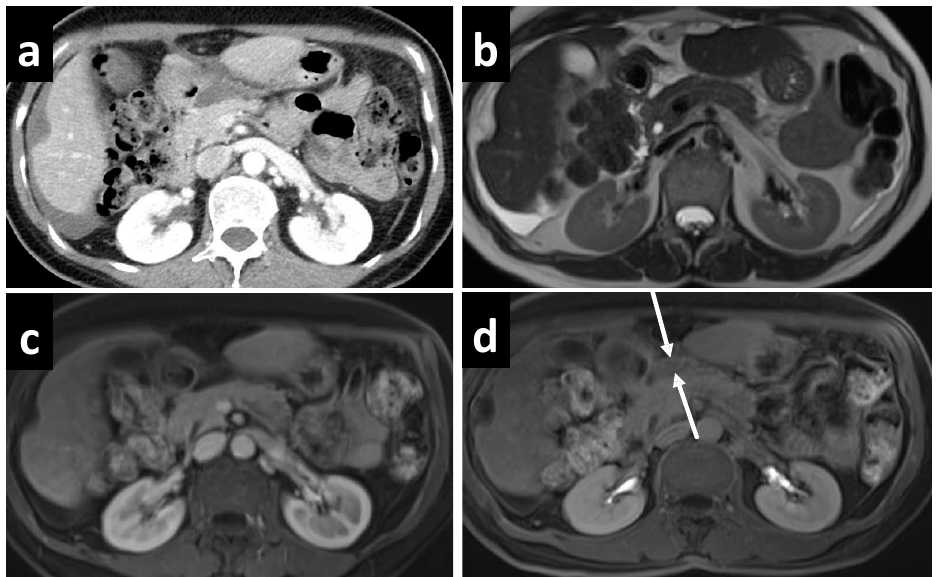
Figure 3. A 61-year-old female with mucinous appendiceal neoplasm, a small amount of fluid is noted within the lesser sac on ( a ) CT and ( b ) T2W MRI. Enhancement within the fluid, however, is barely appreciated on the ( c ) portal venous phase of the MRI, but becomes clearly apparent on the ( d ) delayed MRI.